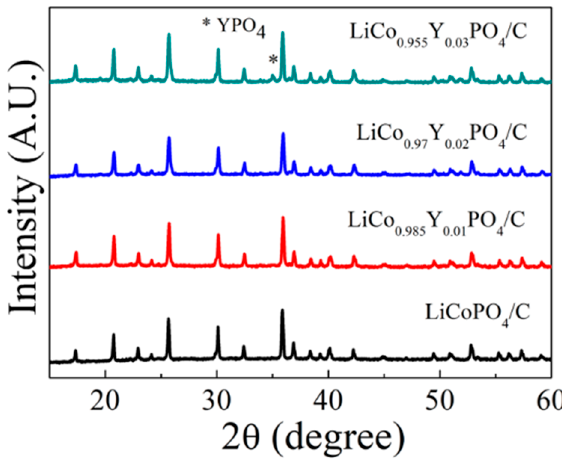
Figure 1. XRD patterns of the four cathode materials.